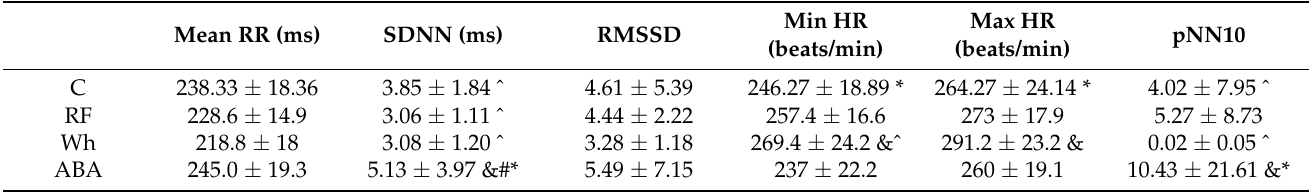
Table 4. HRV time-domain measures. Data expressed as mean ± SD. Statistically significant difference marked as: &—vs. C, #—vs. RF, *—vs. Wh, ˆ—vs. ABA.